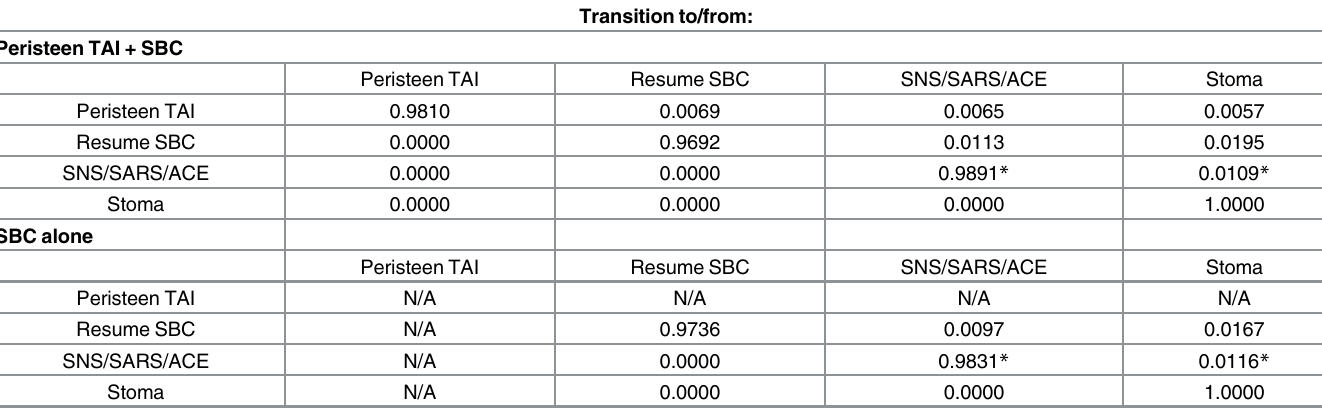
Table 1. Overview of transition probabilities applied in the